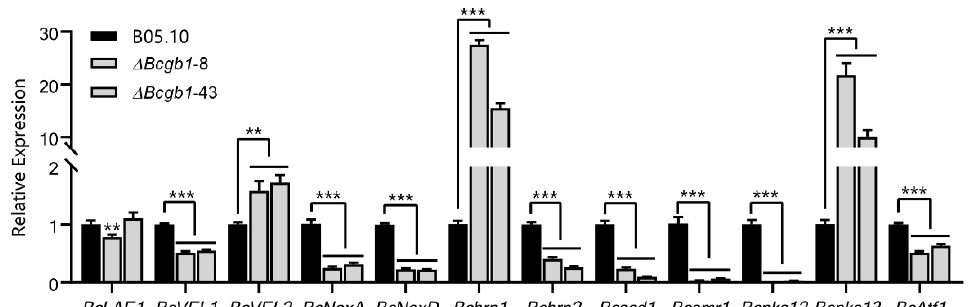
Figure 7. Transcript level of the sclerotia formation-related genes in the WT and the ∆ Bcgb1 mutants of B. cinerea . ** p < 0.01, *** p < 0.001.